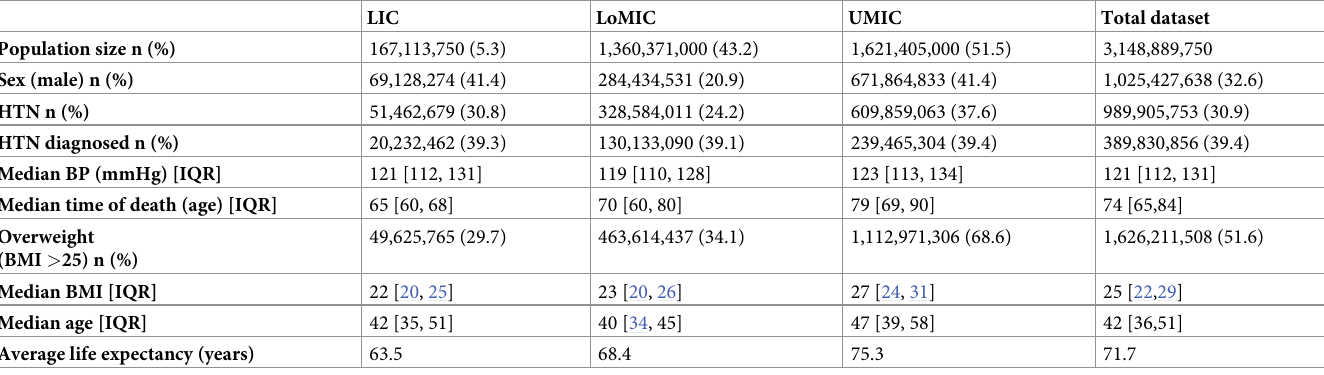
Table 4. Characteristics of the simulated population at initiation. LIC LoMIC UMIC Total